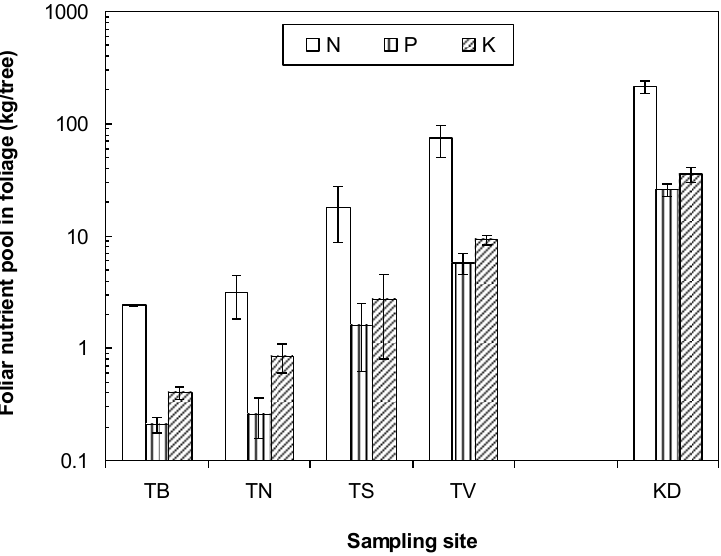
Figure 4. Nutrient pool/annual recruitment of major nutrients (N, P, and K) in foliar biomass of Gmelin’s larch in permafrost-affected (TB, TN, TS, and TV) and permafrost-free sites (KD). Means and standard deviation of three replicates.